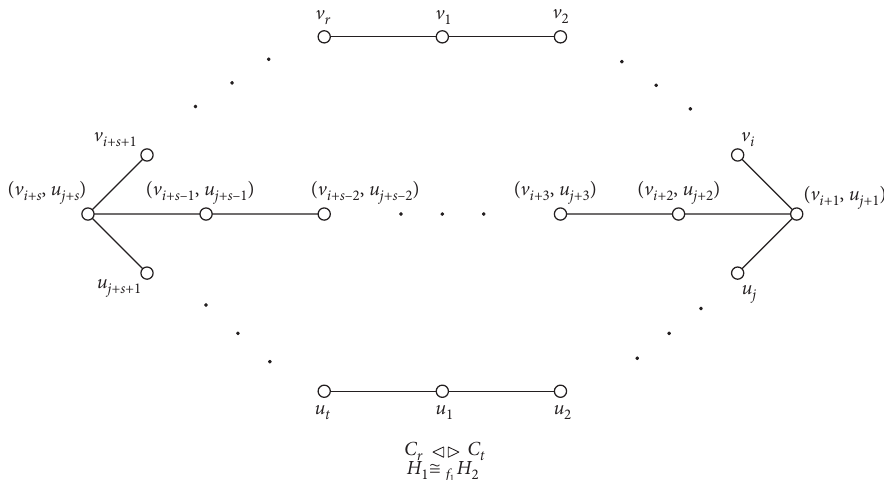
Figure 2: The amalgamation of C